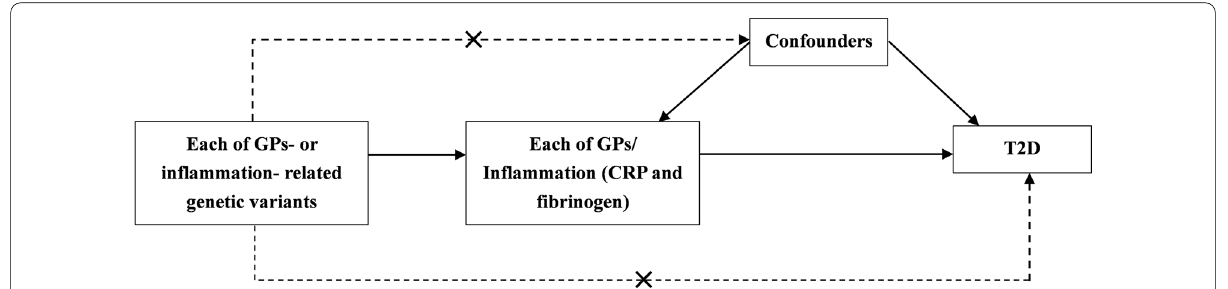
Fig. 1 Design of the current two-sample Mendelian randomization analysis. GP glycan peak, CRP C-reactive protein, T2D type 2